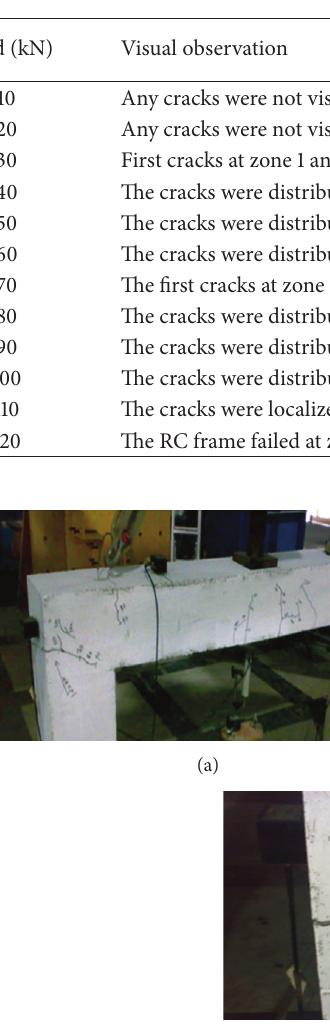
Table 1: A summary of AE source location analysis.